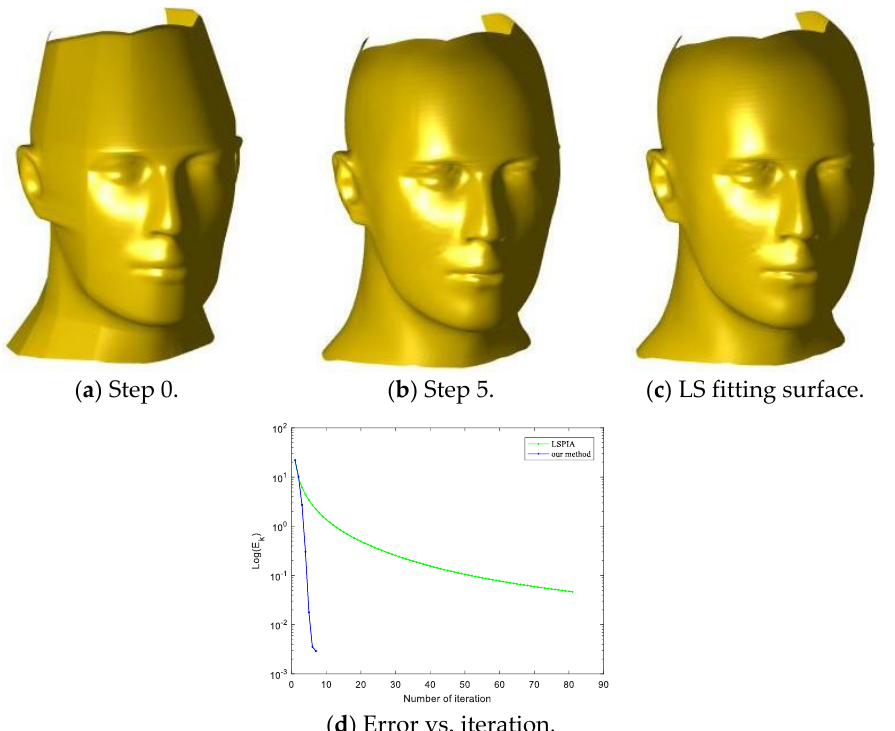
Figure 2. A data point grid with 121 × 161 points was fitted by a bi − cubic tensor product B − spline surface with 60 × 80 control points.